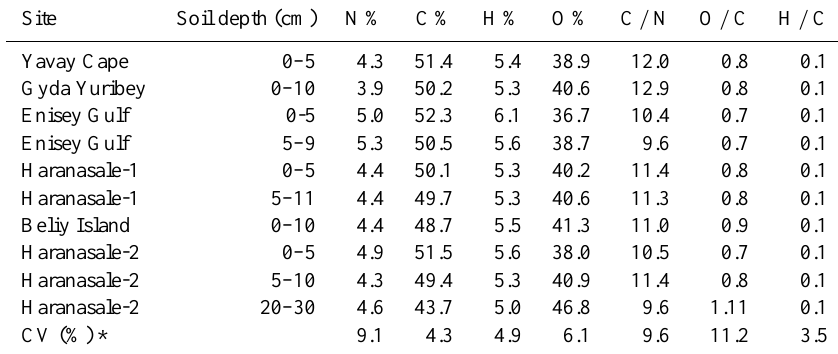
Table 2. Elemental composition and elemental ratios of the extracted humic acids. ∗ Coefficient of variation.